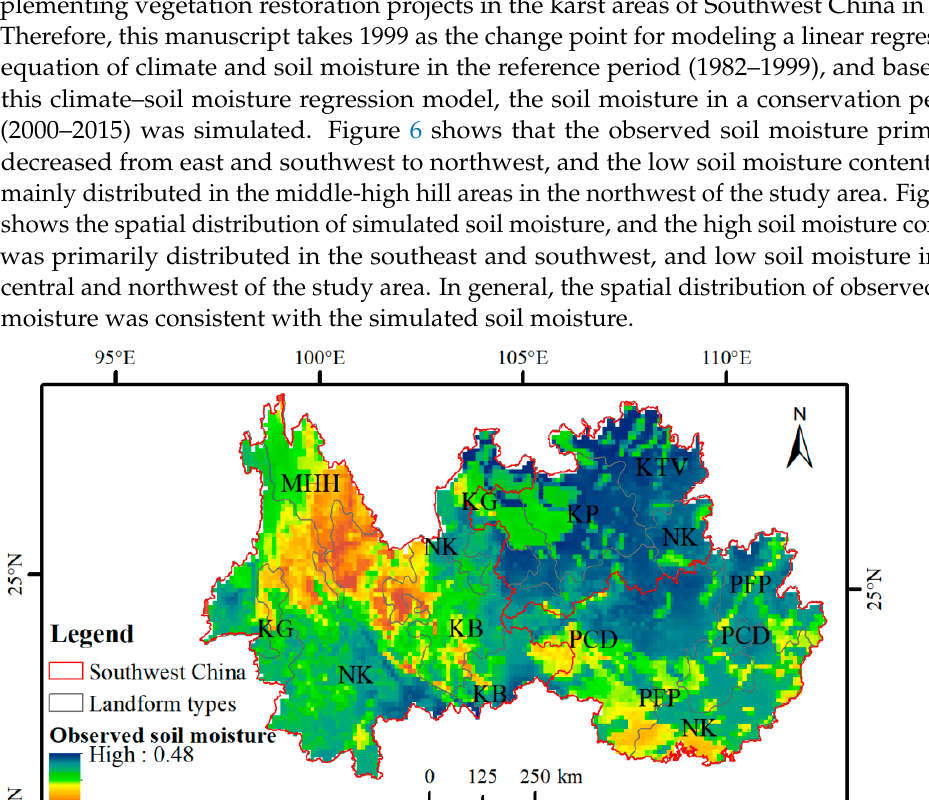
Figure 6. Observed soil moisture in the karst areas of Southwest China from 2000 to 2015 (PFP: peak forest plain; KG: karst gorge; NK: non-karst region; KB: karst basin; MHB: middle-high hill; PCD: peak cluster depression; KTV: karst trough valley; KP: karst plateau).